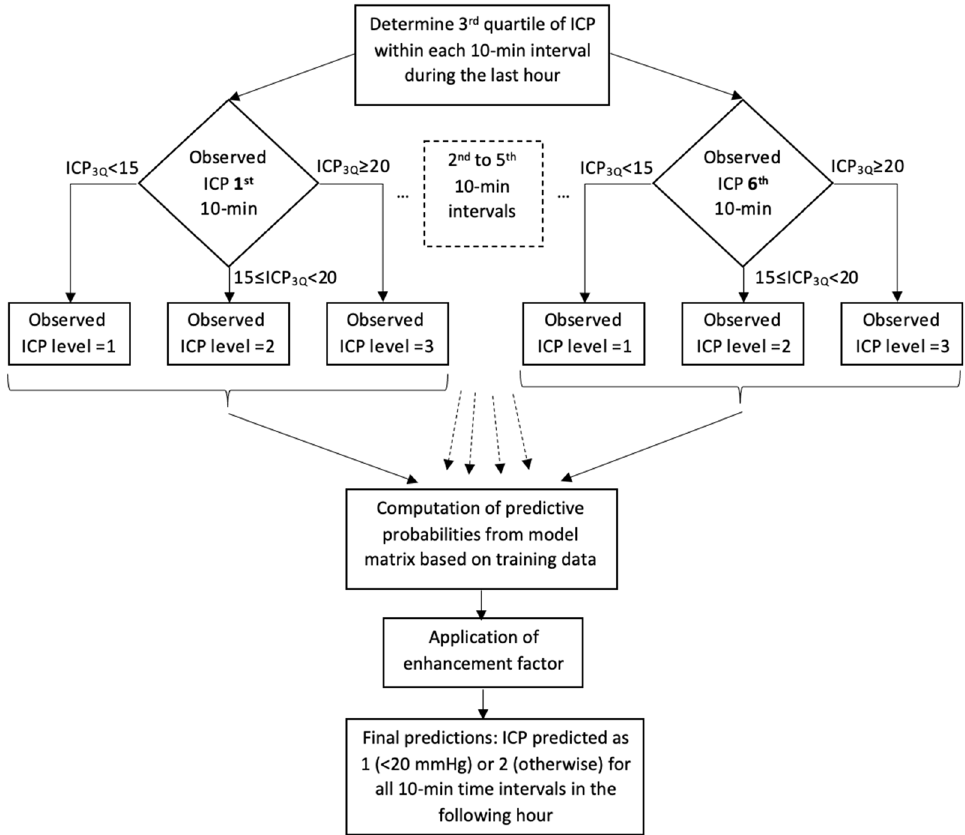
Figure 1. Flow chart for prediction of ICP levels within the next hour to come.